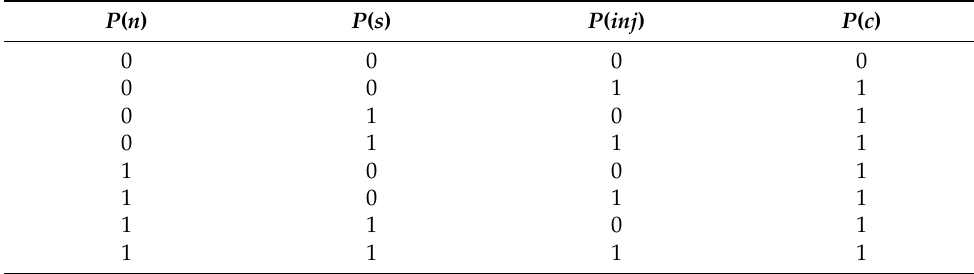
Table 2. Logical binary relationship for the probability of